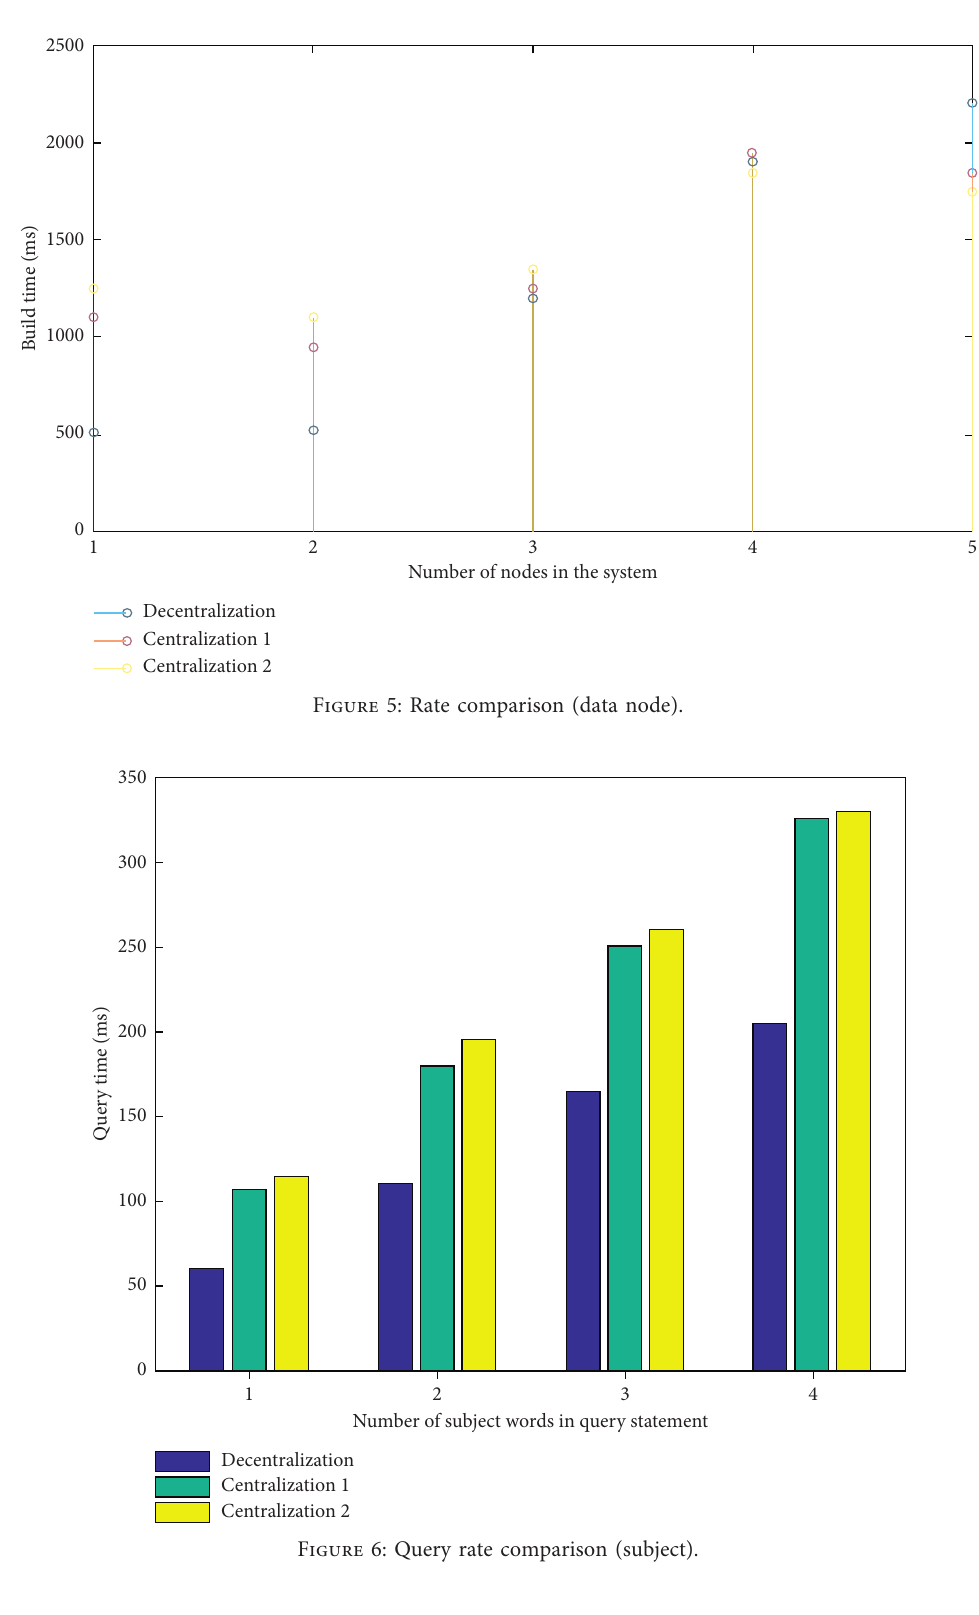
Figure 6: Query rate comparison (subject).